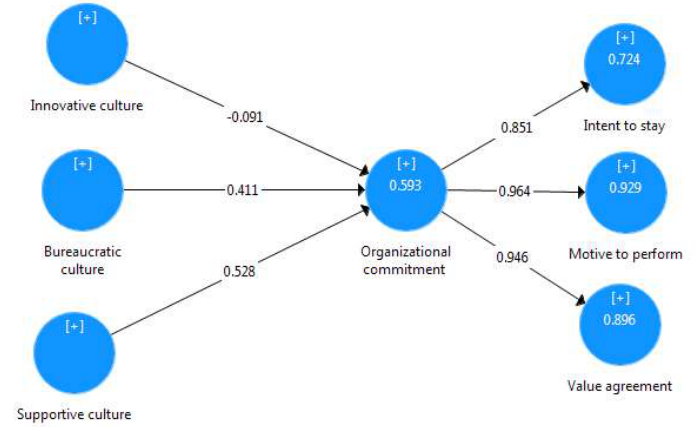
Fig. 2. Relationships between variables in the research